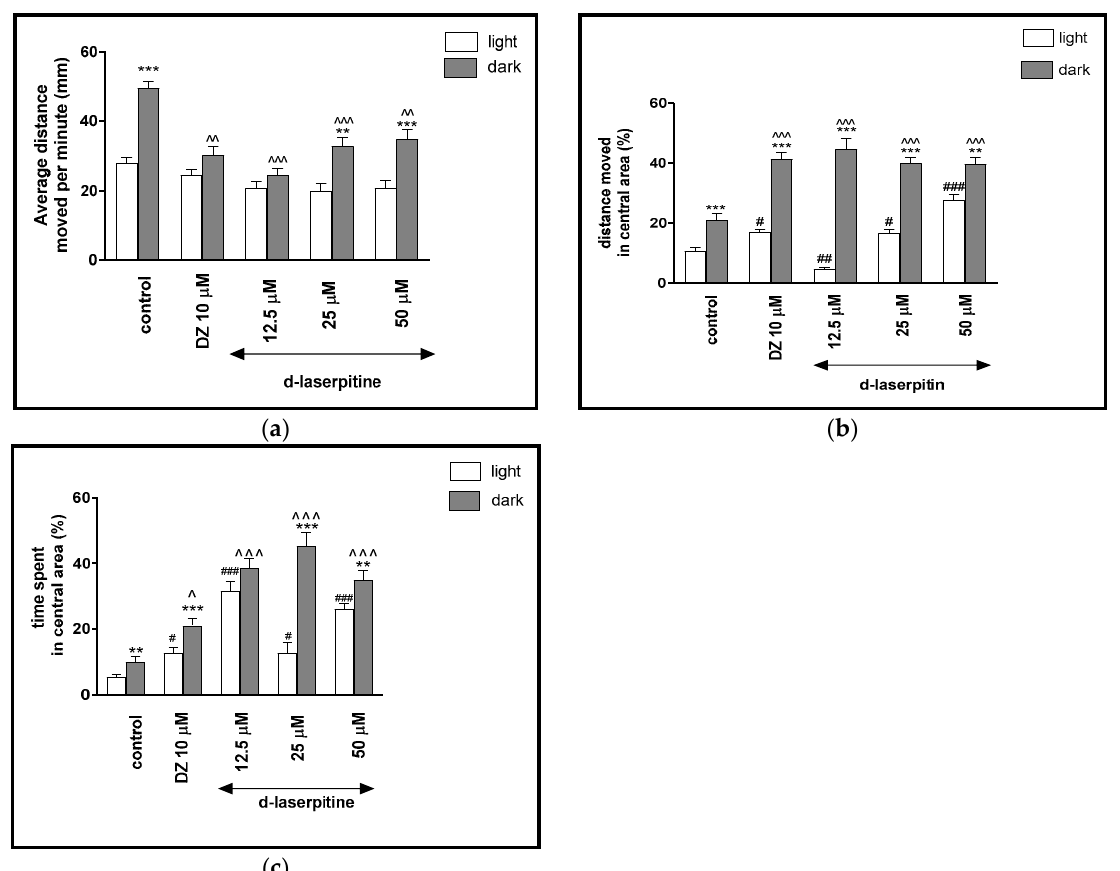
Figure 5. The effects of d-laserpitin (12.5, 25 and 50 µM) and diazepam (DZ, 10 µM) on locomotor activity during all three light–dark challenge phase. ( a ) Average distance moved by zebrafish larvae within each 1-min time bin under either light (open bars) or dark (filled bars). ( b ) The percentage of distance moved by zebrafish larvae in the central area during light phase (white bars) or dark phase (filled bars). ( c ) The percentage of time spent by zebrafish larvae in the central area during light phase (white bars) or dark phase (filled bars). Data are presented as mean ± SEM; n = 32. ** p < 0.01, *** p < 0.001 in comparison to light conditions within the same concentration group; ^ p < 0.05, ^^ p < 0.01, ^^^ p < 0.001 in comparison to control group under dark condition; # p < 0.05, ## p < 0.01, ### p < 0.001 in comparison to control group under light condition (post hoc Bonferroni’s test).